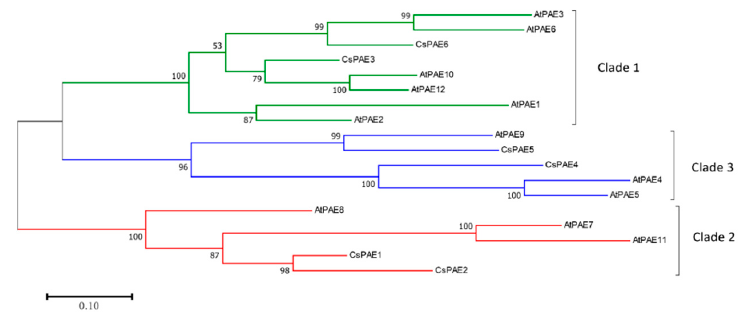
Figure 1. Maximum-Likelihood (ML) phylogeny of all the PAEs from C. sinensis and A. thaliana . An ML tree was constructed based on the PAE amino acid sequences of A. thaliana and C. sinensis (12 and 6, respectively) with MEGA V7.0 (bootstrap = 500, Poisson model). Branches are drawn to scale, with length corresponding to the number of substitutions per site. Sub-family assignments are shown on the right. Clades are color-coded as indicated.